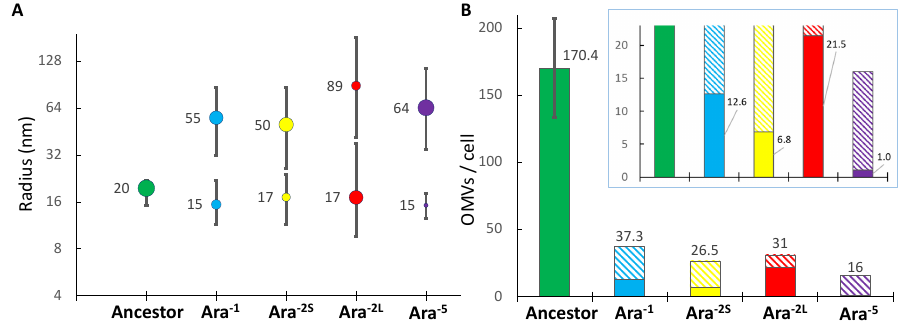
Figure 1. E. coli adaptation to the LTEE conditions causes biophysical changes in OMV production. OMVs were recovered from 1 L culture in DM1000 harvested at mid-log phase of growth for 5 selected clones: the LTEE ancestral strain (REL606) and four 50K-evolved clones isolated from the populations Ara –1 (REL11330), Ara –2 (S lineage, REL11335; L lineage, REL11333) and Ara –5 (REL11339). ( A ) Weighted average radii of OMVs as determined using Dynamic Light Scattering. Colored dots and associated values indicate the weighted average radius for one or two OMV size ranges for which both the lower and the upper bounds are indicated by the vertical bars. The surface of each dot is proportional to the OMVs’ abundance in each size range. ( B ) Number of OMVs produced per cell calculated as indicated in the material and methods section and detailed in Figure S1C. Non-hatched and hatched histograms correspond to small and large OMVs, respectively. The total number of OMVs produced per bacterial cell is indicated above each histogram. The inset panel corresponds to the same data but re-scaled to allow visualization of the number of small OMVs produced per cell by each evolved clone. For the ancestral strain (Ancestor), the value corresponds to the mean of 5 replicates (error bar shows the standard deviation). For the evolved clones, the value is from one